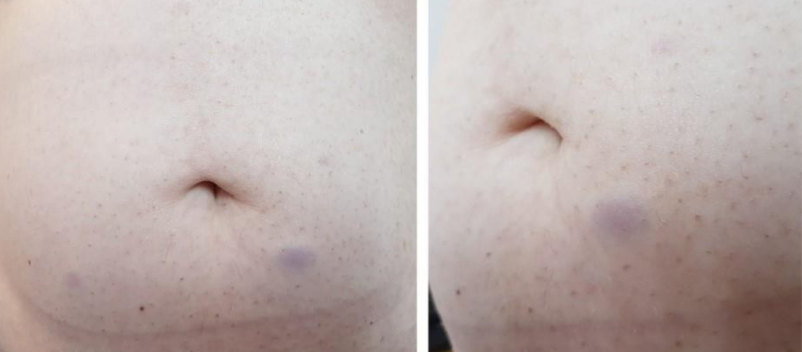
Figure 4. Asymptomatic, violaceous subcutaneous tumors in the abdominal area-pseudoatrophic macules typically found in NF1 (scale 1:11 /